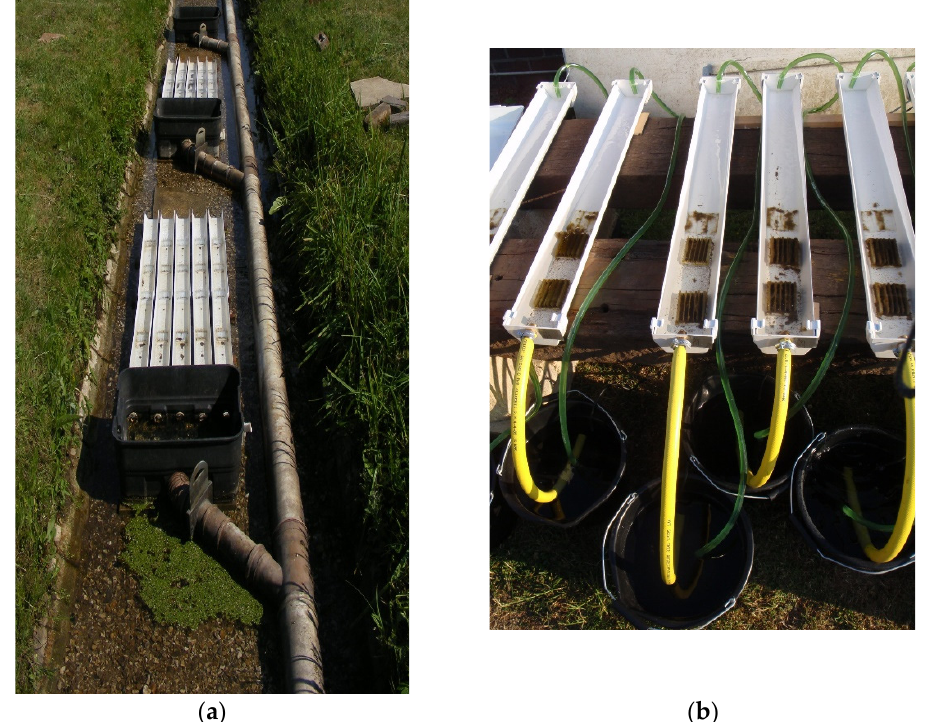
Figure 1. ( a ) Experimental stream channels at the former FBA Rivers Lab, Dorset, UK, fed directly from the Mill Stream. Glass slides, held in phytometers, were used to grow phytobenthic biofilms. ( b ) Self-contained flumes with recirculating water for short-pulse herbicide treatment.